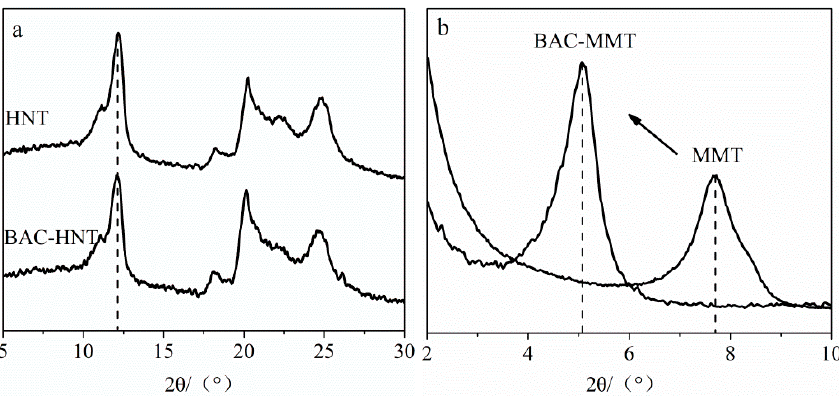
Figure 5. XRD patterns of ( a ) HNT- and ( b ) MMT-loaded BAC before and after.